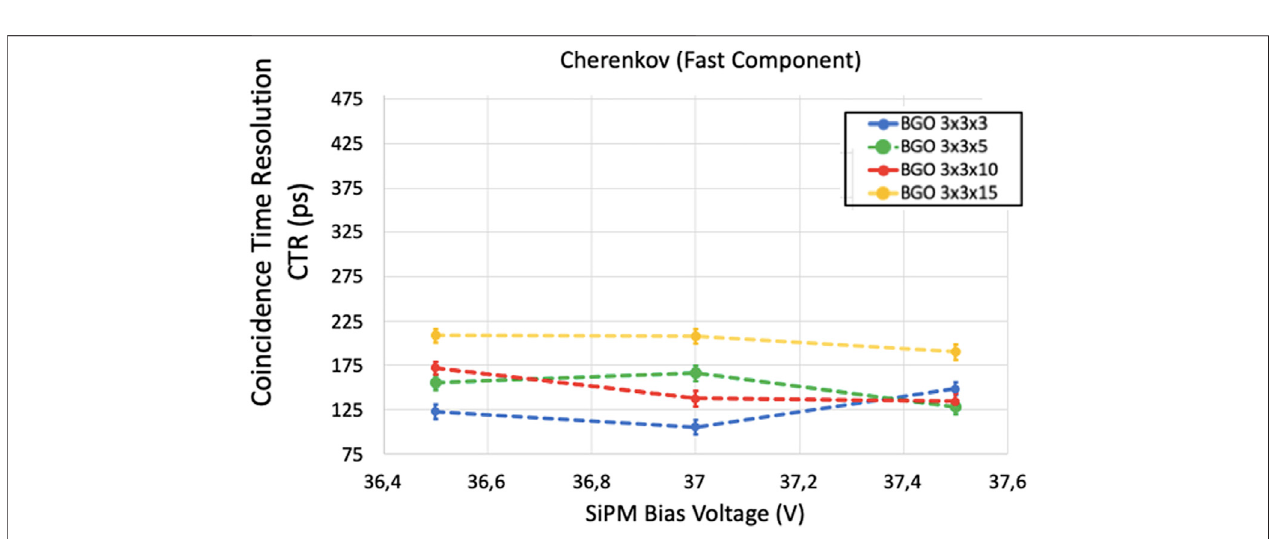
FIGURE8| FWHMCTRvaluesachievedwhenonlyconsideringthefast(Cherenkov)componentofthetimingsignal,asafunctionoftheSiPMbiasvoltageforeach crystal length after applying both delay and classi fi cation corrections.